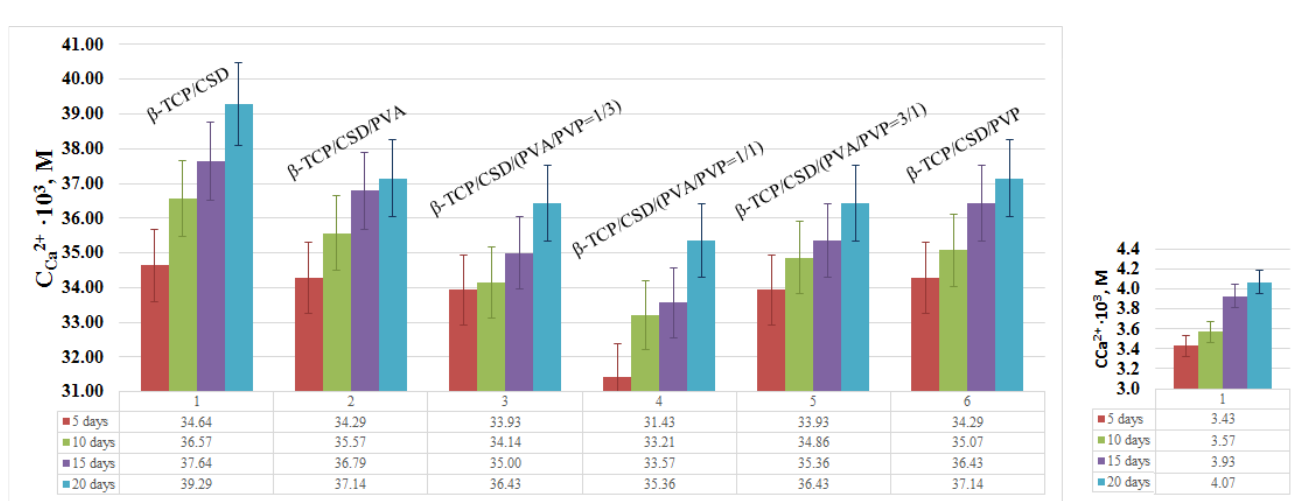
Figure 7. Release of Ca 2+ ions within 20 days for the composites and the initial β -TCP.